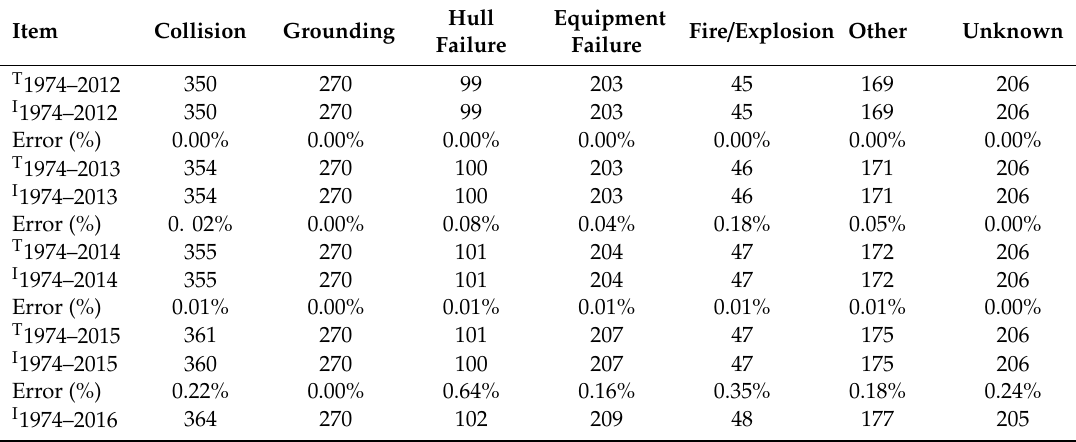
Table 8. Analysis of results of oil spills of 7-700 tons from 1974 to